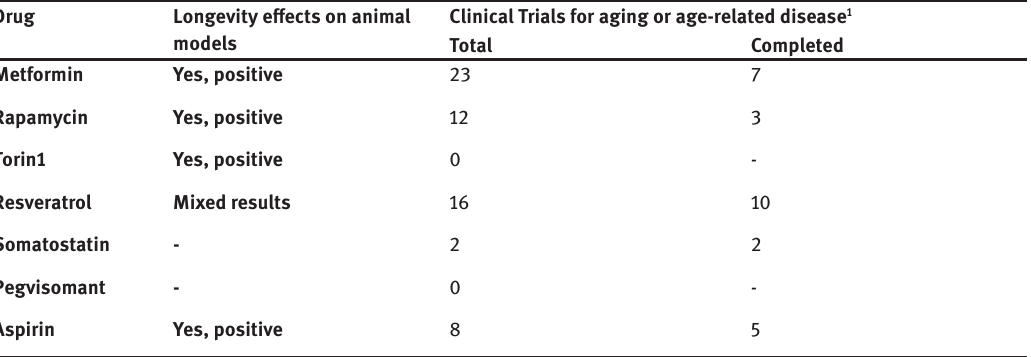
Table 1: Drugs discussed in the manuscript, their effects on the lifespan of animal aging models and clinical studies in humans related aging and aging phenotype. The effects of somatostatin and pegvisomant on animal aging rates, median and maximal lifespans is unclear. The bar sign (–) within the clinical studies column of the table designates that there are no studies for direct effect on human lifespan to date (data from clinicaltrials.gov as of 30.11.18). Longevity effects on